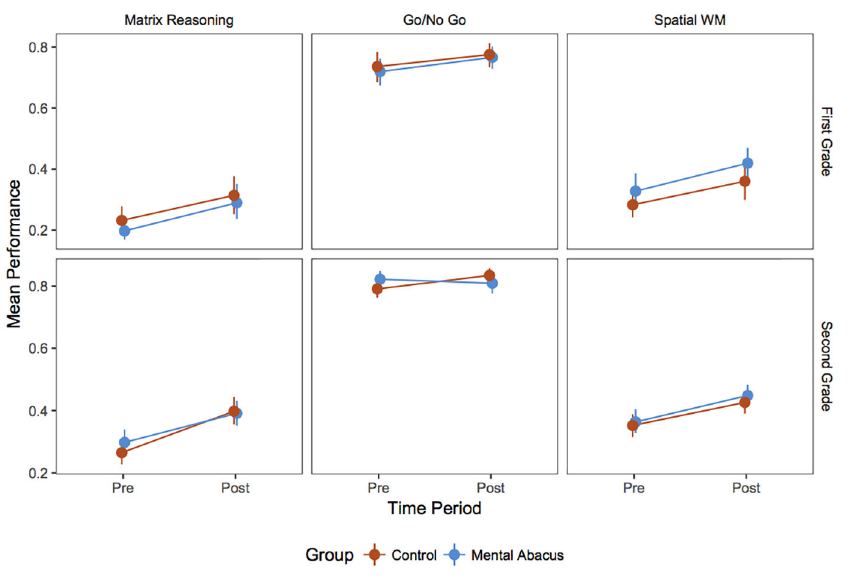
Figure 5. Performance on cognitive measures by time and grade. Error bars show 95% confidence intervals, computed by non-parametric